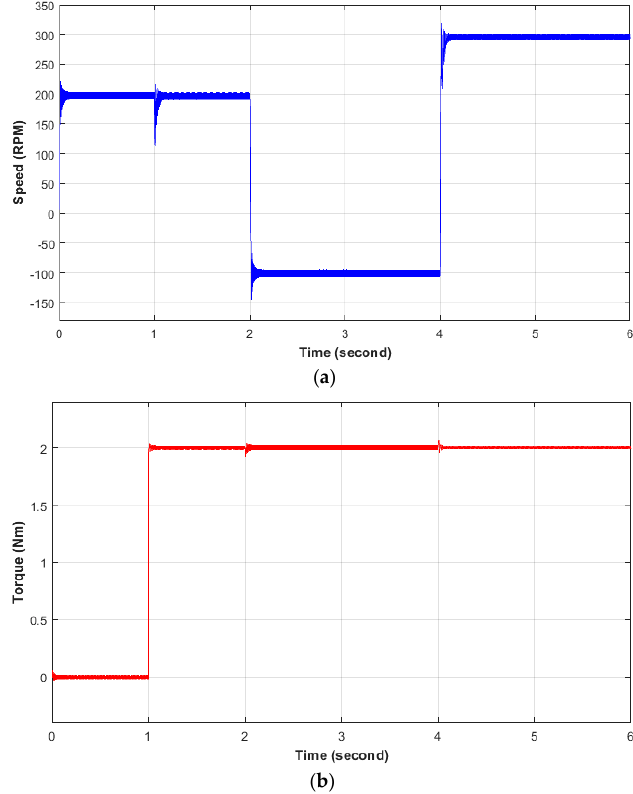
Figure 5. Simulation results: ( a ) BLDC motor speed (rpm); ( b ) electrical torque (Nm).